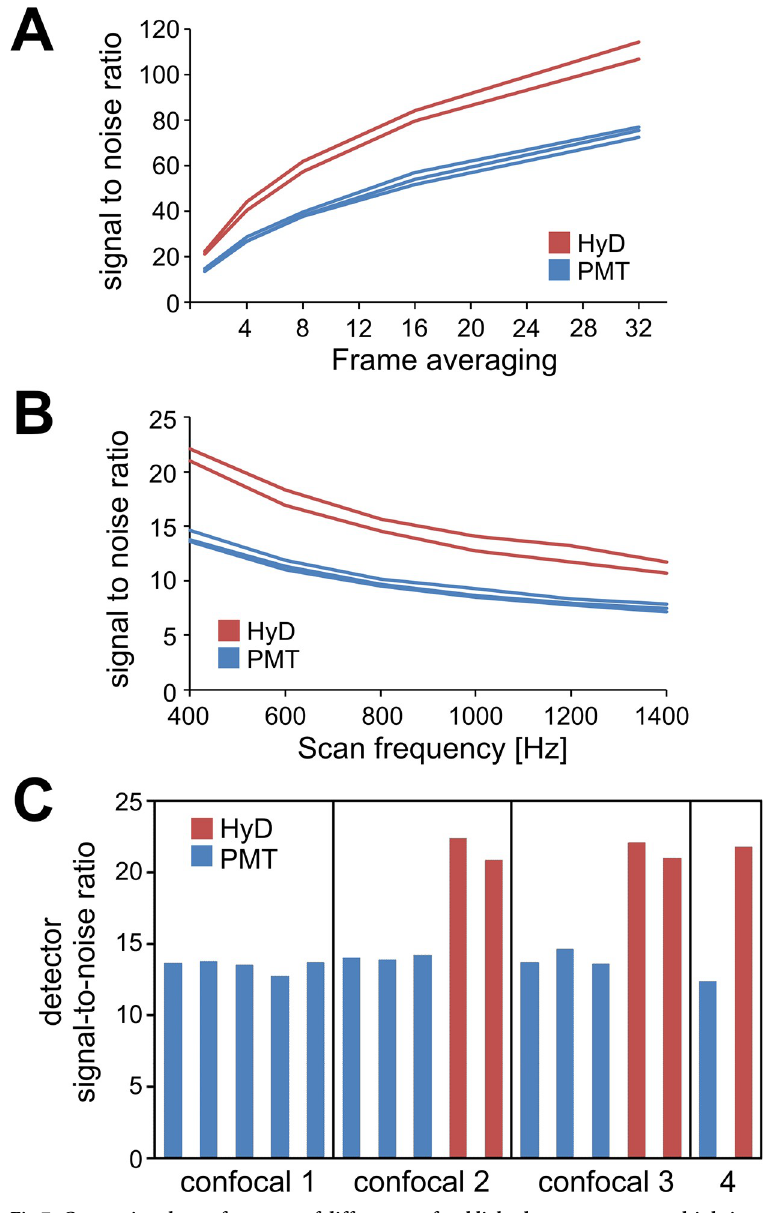
Fig 7. Comparing the performance of different confocal light detectors across multiple instruments. (A) Effect of frame averaging on the signal-to-noise ratio of the five detectors on a Leica confocal microscope. (B) The decrease in pixel dwell time due to the increase in scan speed causes the reduction of the signal-to-noise ratio—same detectors as in (A). (C) The signal-to-noise ratio of images acquired with the stable output from the LED mounted on the colour sensor circuit board is useful to compare and characterise different confocal detector types (photomultiplier tubes, PMT, versus hybrid detectors, HyD) across multiple Leica confocal microscopes. The HyD detectors provide a significant improvement over the photomultiplier